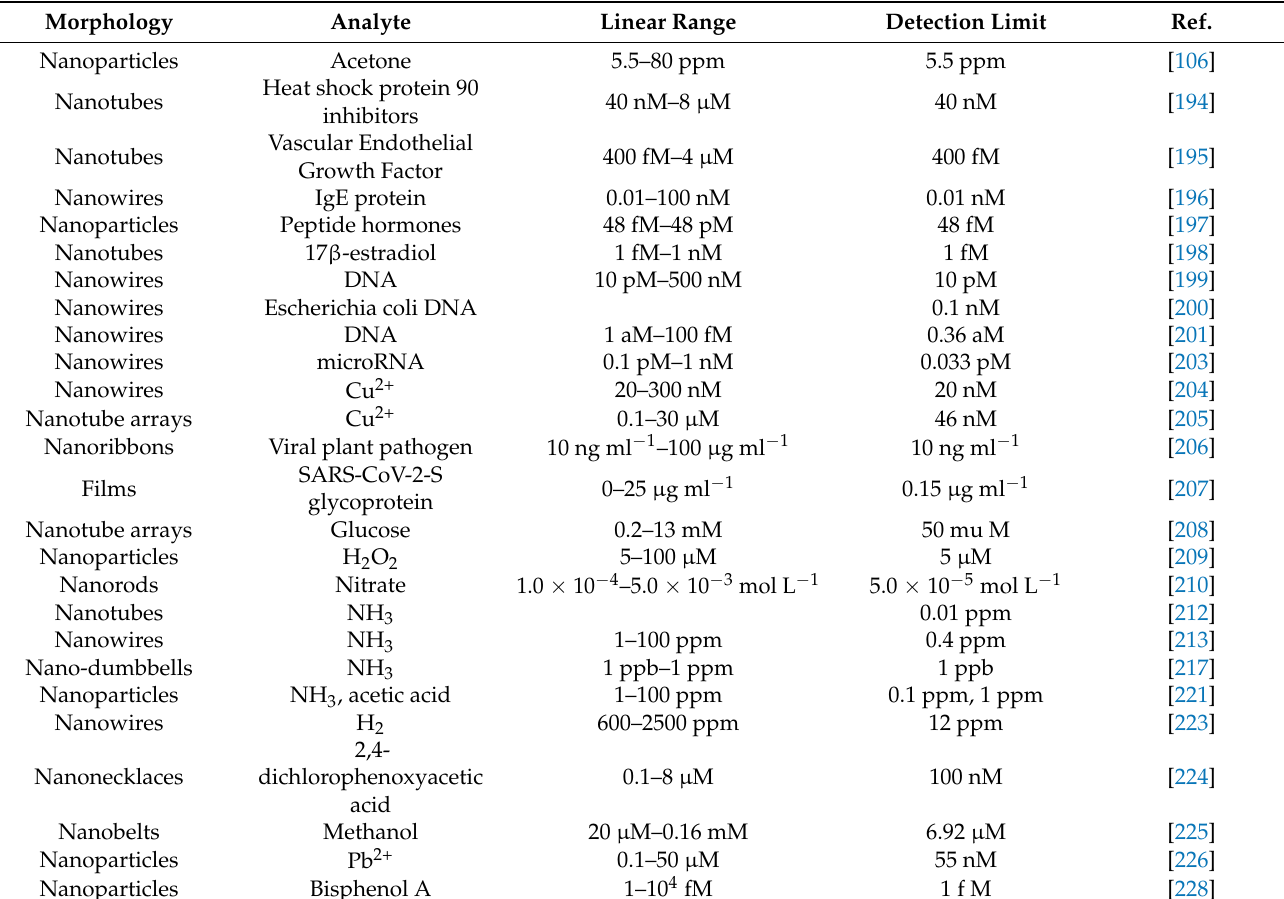
Table 4. A summary of PPy nanomaterials for